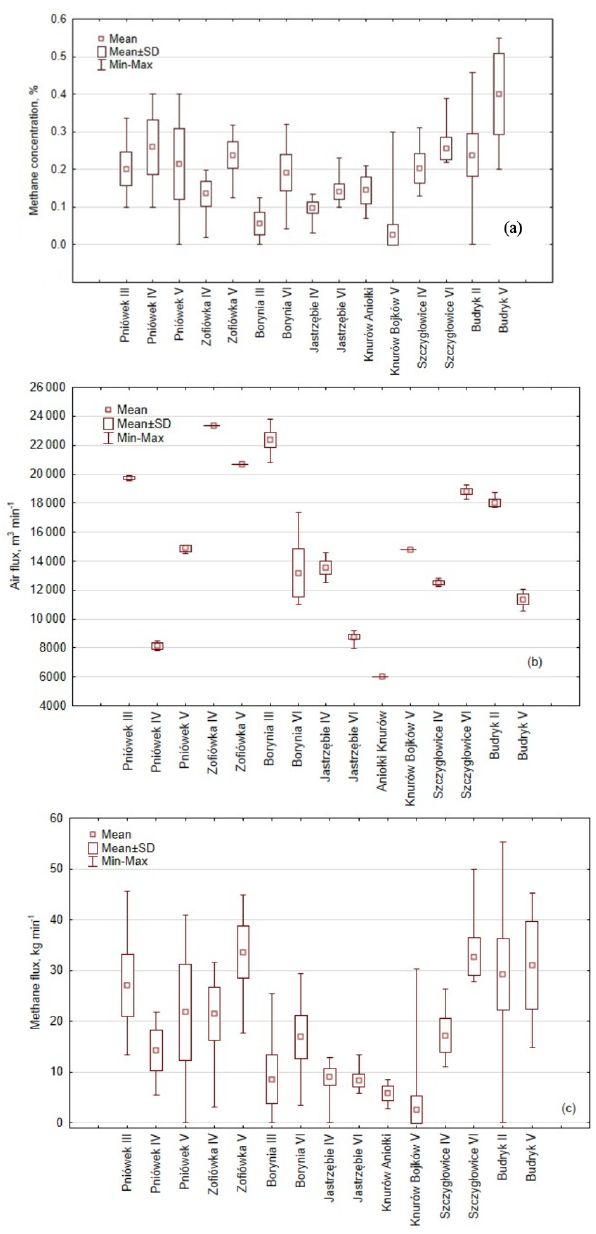
Figure 6. Changes in methane concentration (a) , air flux (b) , and methane flux (c) in the investigated shafts within the CoMet 1.0 observation period from 14 May to 13 June